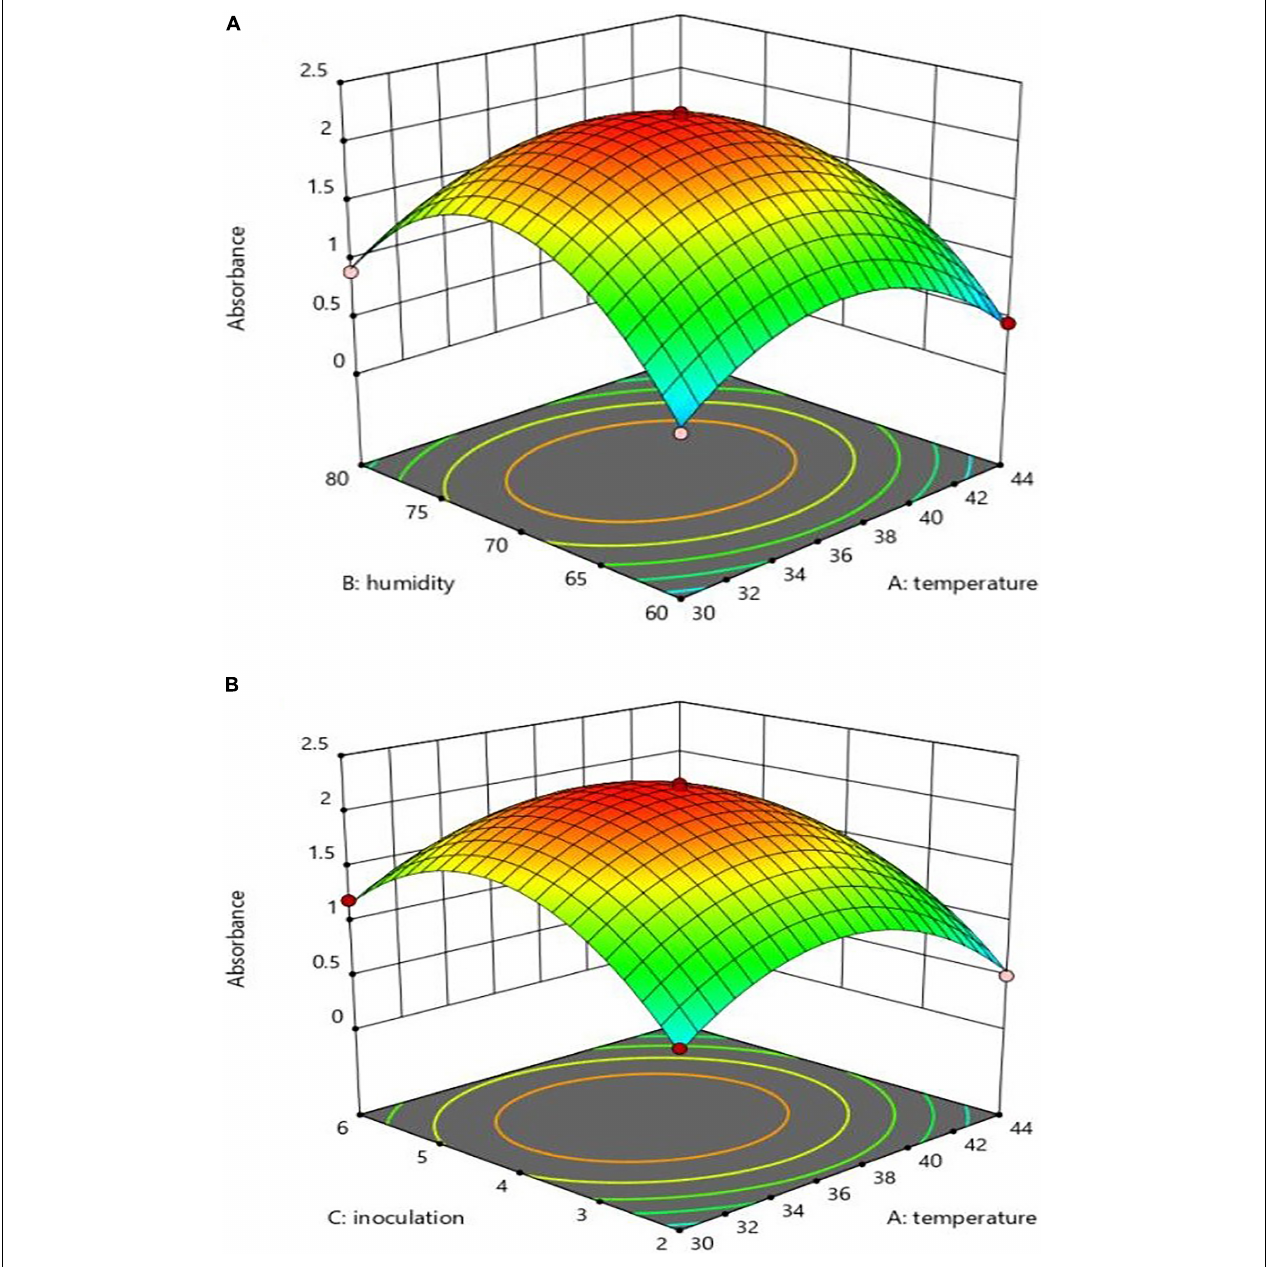
FIGURE 3 | Interaction effect of temperature and inoculation (A) , and temperature and humidity (B) on